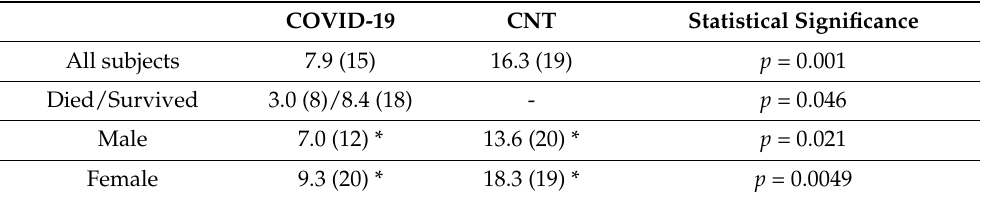
Table 3. Vitamin D serum levels in COVID-19 patients and control subjects (CNT). 25OH-vitamin D values (ng/mL) are reported as median and interquartile range